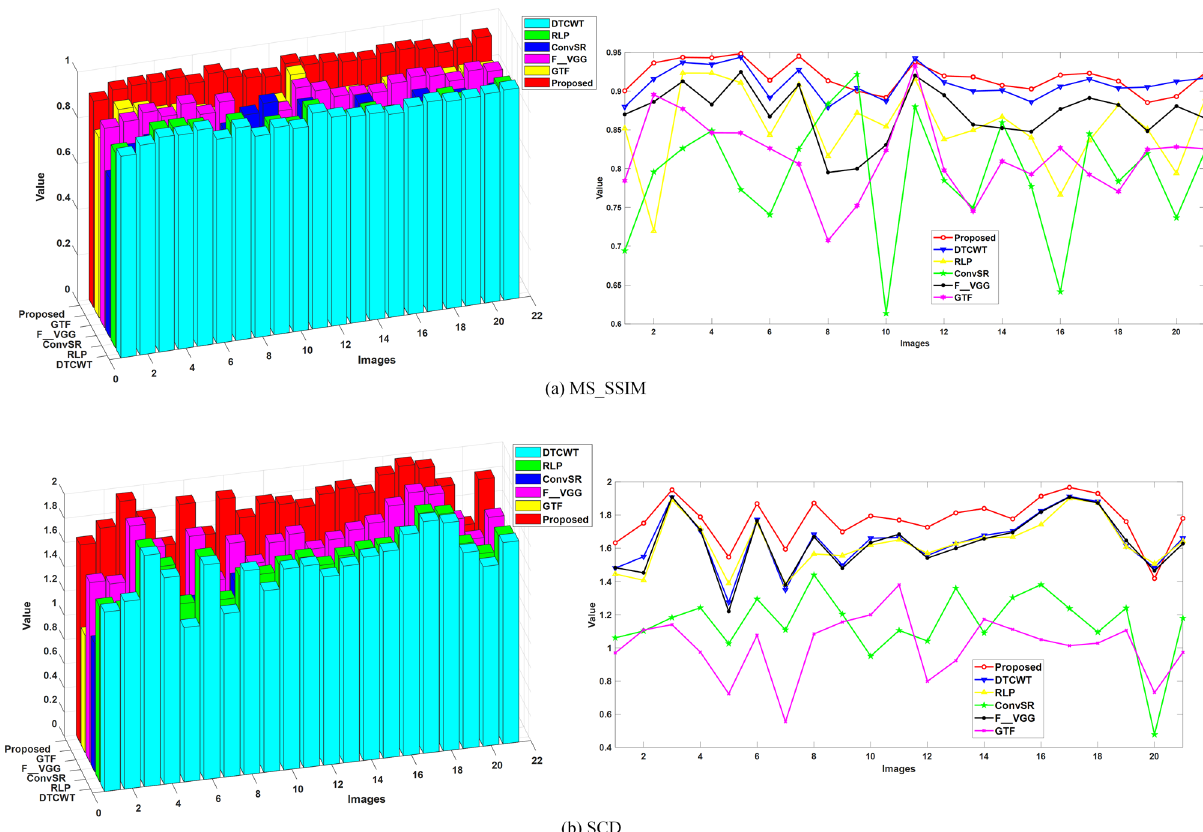
Figure 10. Quantitative comparisons of the metrics (for metrics, larger values indicate better